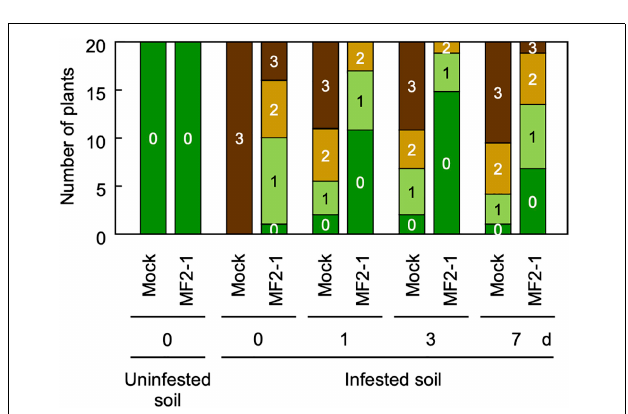
FIGURE 4 | Persistence of biocontrol effect after pre-inoculation of melon seedlings with (cid:49) FOW2 strain. Roots of melon seedlings were dipped in a conidial suspension (1 × 10 8 conidia/mL) of (cid:49) FOW2 strain MF2-1 or in water, and seedlings were planted in soil infested with wild-type strain Mel02010 (1 × 10 5 conidia/g soil) or in uninfested soil. After 1, 3, or 7 days, seedlings grown in uninfested soil were transplanted in Mel02010 infested soil. Symptoms were scored 3 weeks after planting in infested soil as 0, no symptoms; 1, yellowing; 2, wilted; 3, dead.